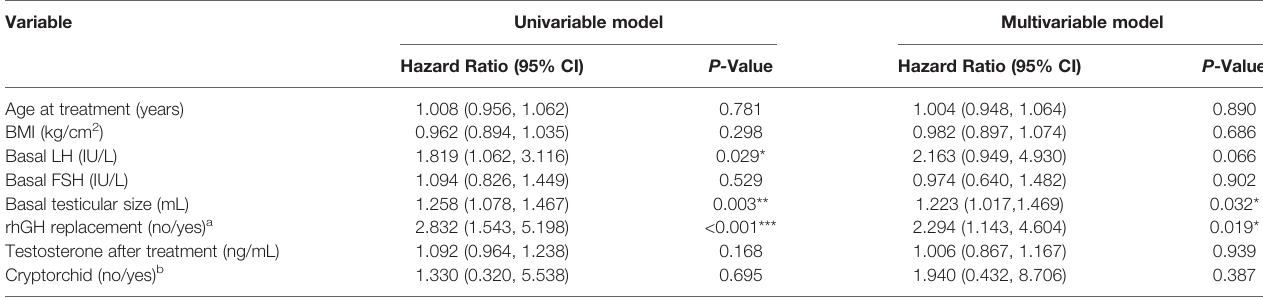
TABLE 3 | Hazard ratios (95% CIs) of rhGH replacement to spermatogenesis.